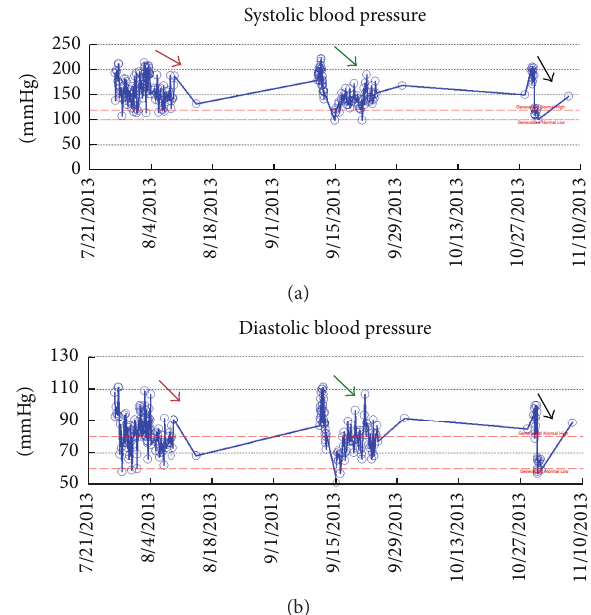
Figure 1: Data points showing systolic blood pressures (a) and diastolicbloodpressures(b).Differentcoloredarrowsshowdifferent hospital admissions. The arrows depict the improvements in blood pressures after treatment of Acute Page